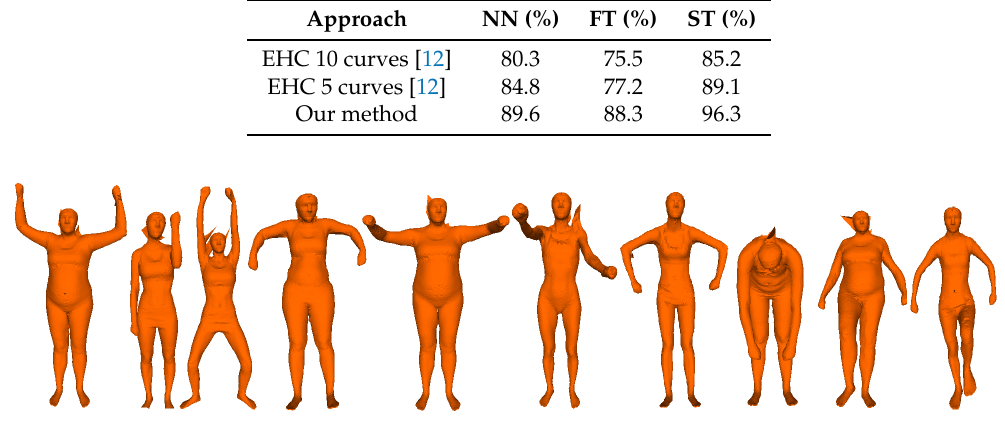
Figure 18. Ten used representative human poses with different subjects in the statistical shape database [2], where some artifacts are